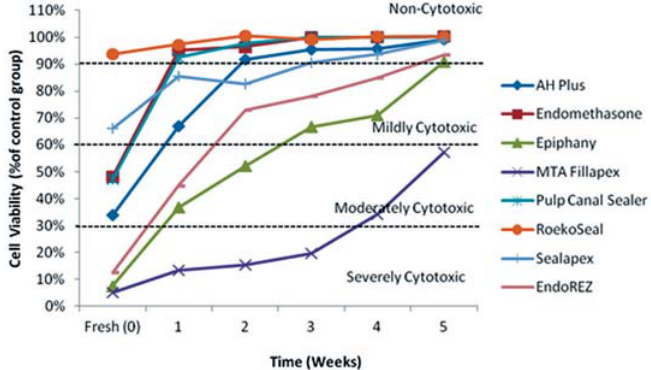
Figure 2- Line chart depicting the changes in cell viability over time after the eight endodontic sealers were repeatedly (cid:14)$$(cid:11)(cid:4)(cid:10)(cid:11)(cid:24)(cid:12)(cid:14)(cid:7)(cid:12)(cid:3)(cid:12)(cid:10)(cid:14)$(cid:26)(cid:15)(cid:3)(cid:23)(cid:11)(cid:24)(cid:12)(cid:9)(cid:21)(cid:24)&(cid:12)’(cid:26)(cid:14)(cid:24)(cid:31)(cid:12)*(cid:3)(cid:15)(cid:26)(cid:11)(cid:10)(cid:12)(cid:3)(cid:4)(cid:11)(cid:12)(cid:11)(cid:18)(cid:22)(cid:4)(cid:11)(cid:10)(cid:10)(cid:11)(cid:24)(cid:12)(cid:3)(cid:10)(cid:12)(cid:22)(cid:11)(cid:4)(cid:19)(cid:11)(cid:7)(cid:23)(cid:3)(cid:27)(cid:11)(cid:10)(cid:12)(cid:4)(cid:11)(cid:15)(cid:3)(cid:23)(cid:14)+(cid:11)(cid:12)(cid:23)(cid:21)(cid:12)(cid:23)(cid:20)(cid:11)(cid:12)(cid:19)(cid:21)(cid:7)(cid:23)(cid:4)(cid:21)(cid:15)(cid:12)(cid:27)(cid:4)(cid:21)(cid:26)(cid:22)(cid:12)(cid:3)(cid:7)(cid:24)(cid:12)(cid:19)(cid:15)(cid:3)(cid:10)(cid:10)(cid:14)(cid:6)(cid:11)(cid:24)(cid:12)(cid:3)(cid:10)(cid:12) (cid:10)(cid:11)+(cid:11)(cid:4)(cid:11)(cid:12)(cid:28)(cid:29);(cid:30)<"(cid:16)(cid:12)$(cid:21)(cid:24)(cid:11)(cid:4)(cid:3)(cid:23)(cid:11)(cid:12)(cid:28)(cid:29)=(cid:30)<"(cid:16)(cid:12)$(cid:14)(cid:15)(cid:24)(cid:12)(cid:28)=(cid:30)(cid:8)>(cid:30)<"(cid:12)(cid:21)(cid:4)(cid:12)(cid:7)(cid:21)(cid:7)(cid:8)(cid:19)&(cid:23)(cid:21)(cid:23)(cid:21)(cid:18)(cid:14)(cid:19)(cid:12)(cid:28)?>(cid:30)<"